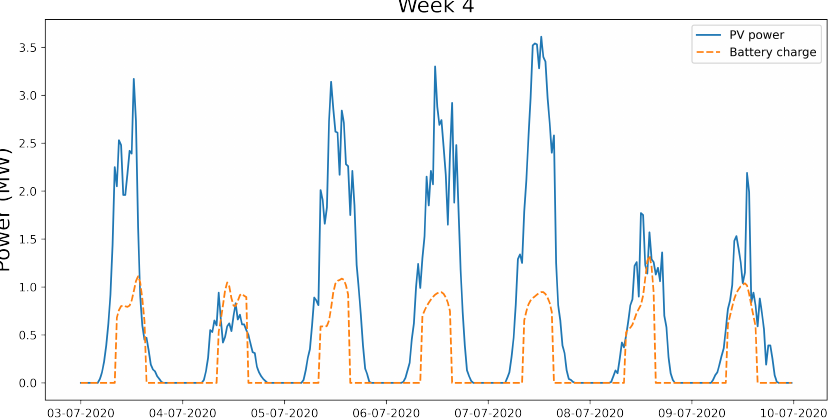
Figure 9. Comparison between the battery charge pattern and the PV power generation for week 4. When the battery charge is greater than the PV power, the difference is taken from the grid.